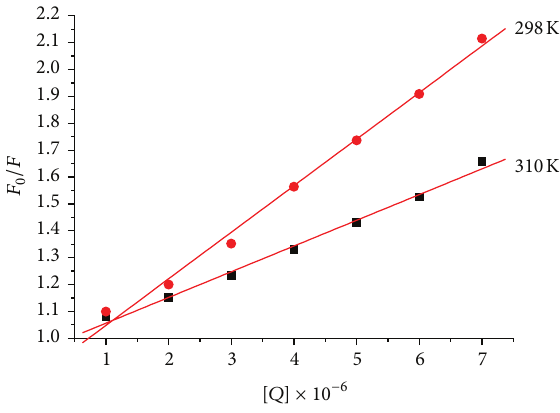
Figure 3: Stern-Volmer plots of Hyp-HSA at different temperatures, 𝐶 (